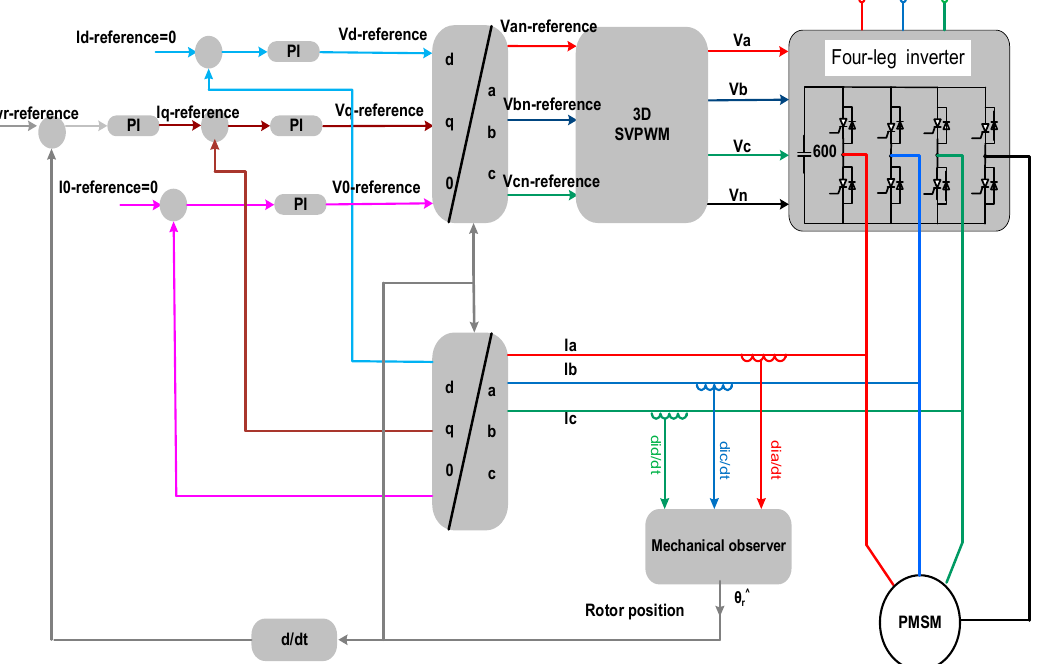
Figure 11. Closed-loop field-oriented encoderless speed control topology using 3D-SVPWM under a loss of one phase.